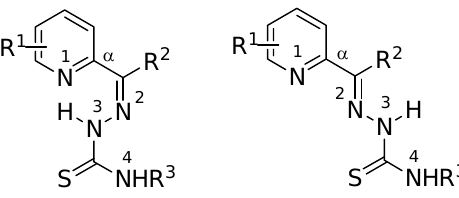
Figure 1. Strutures of α -(N)-heterocyclic thiosemicarbazones: R 1 -R 3 = hydrogen, alkyl group or aryl group; Z (left) and E (right) geometrical